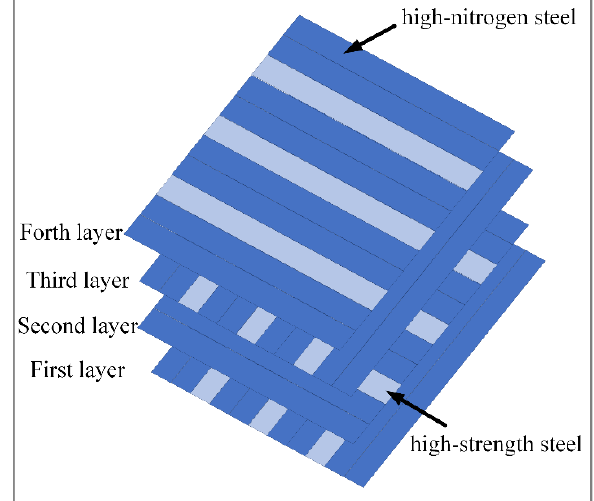
Figure 23. Schematic of FGMs by PA-AM [92].